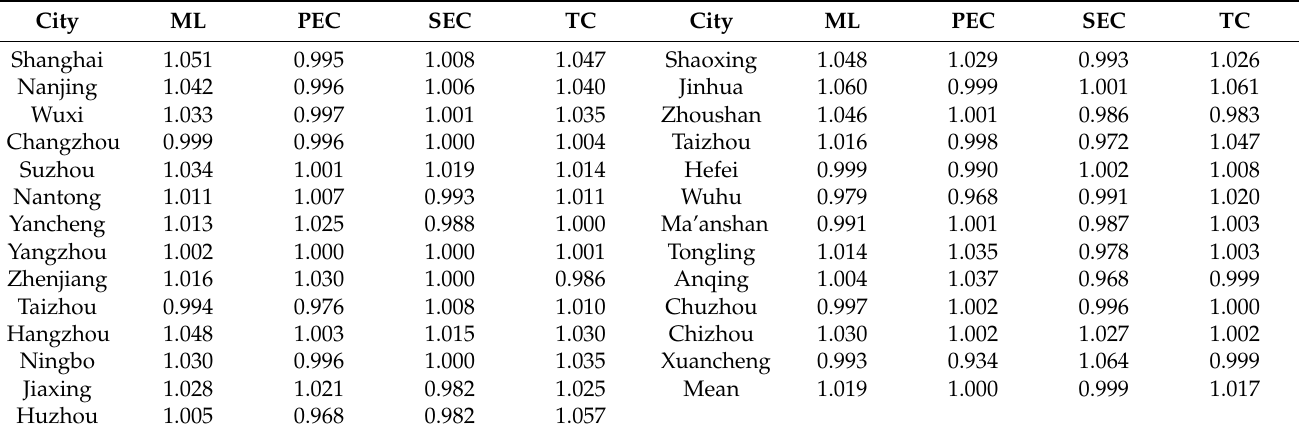
Table 4. The Annual Malmquist Index and Its